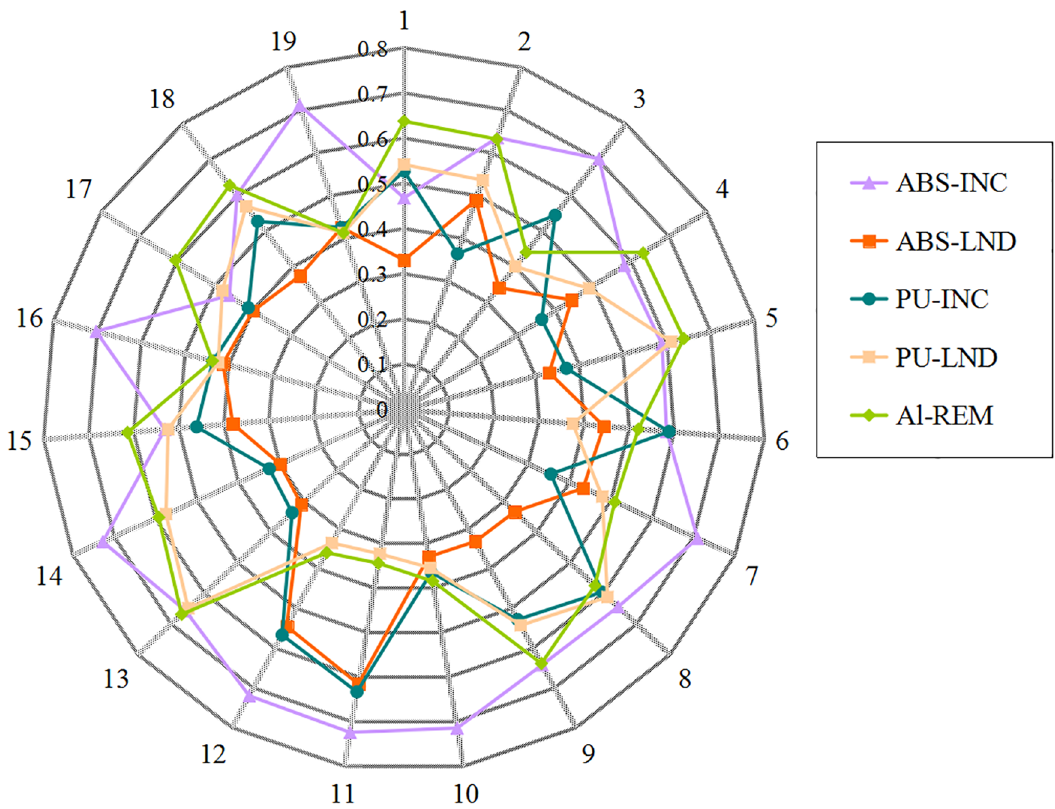
Fig 4. Sensitivity